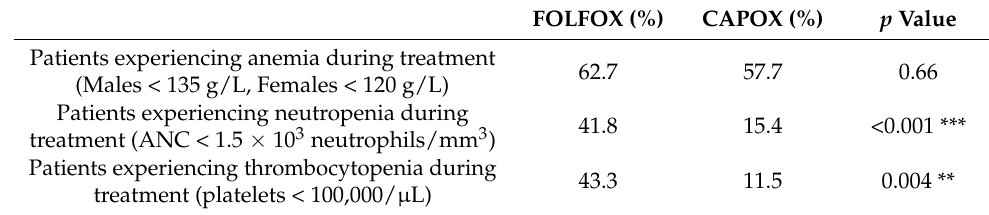
Table 5. Proportion of Patients Experiencing Treatment-Related Cytopenias. FOLFOX (%) CAPOX (%) p Value Patients experiencing anemia during treatment (Males < 135 g/L, Females < 120